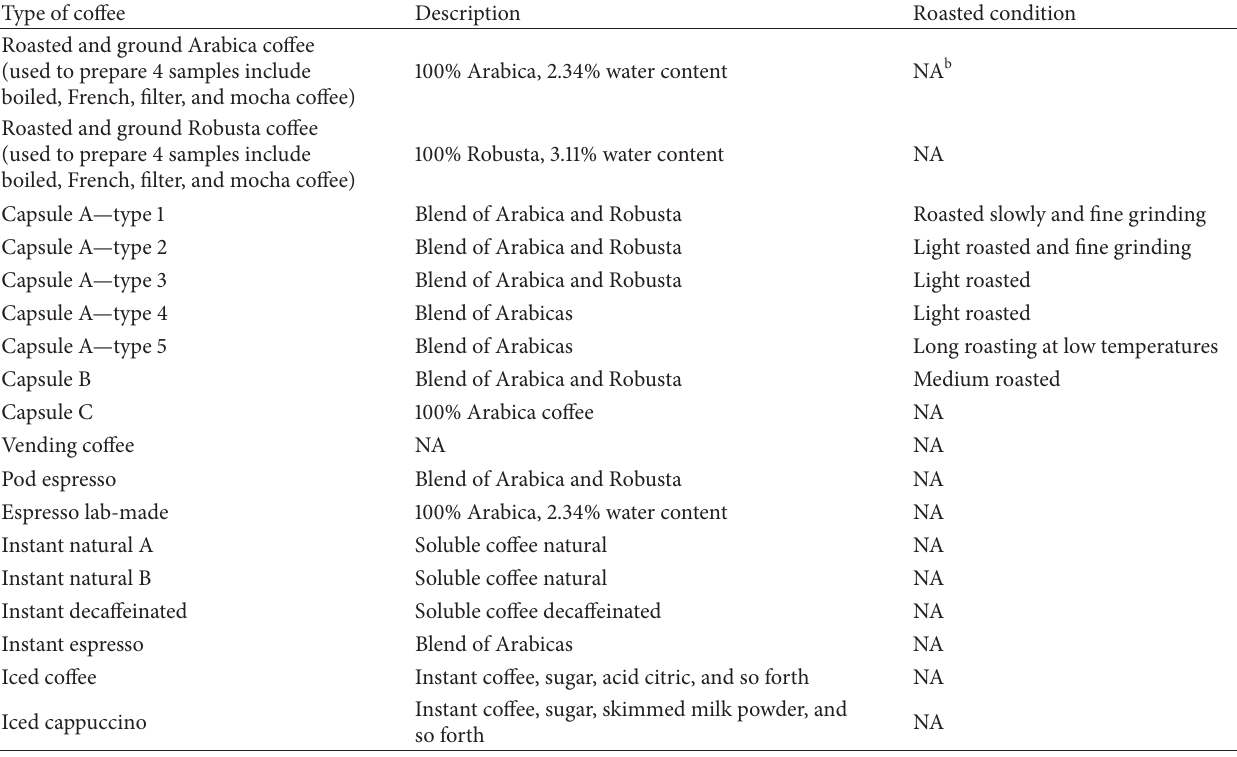
Table 1: General description of ground coffees used for preparation of various types of coffee brews studied in the present work a . Type of coffee Description Roasted condition Roasted and ground Arabica